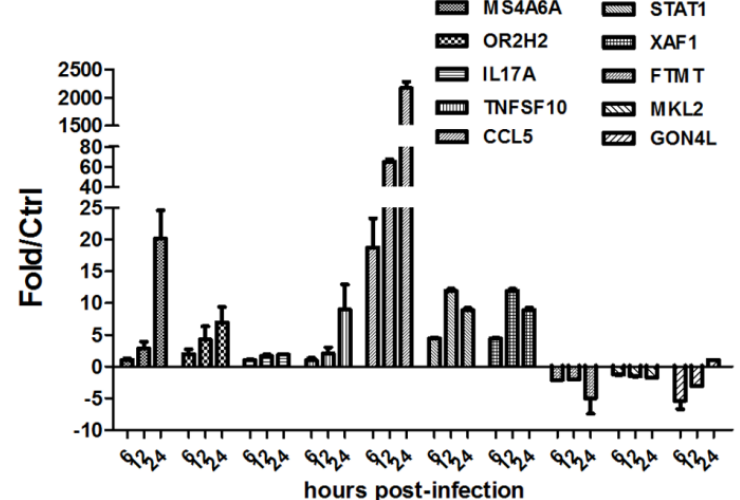
Figure 3. Validation of the microarray data by qRT-PCR. Ten genes with different expressions were selected for RT-PCR confirmation. GAPDH was used for normalization. Data was mean ± SEM of triplicate reactions for each gene. Fold change was calculated using the comparative Ct method. Statistical significance from control infection was analyzed by student’s t -test. * p < 0.05, ** p <0.01, *** p <